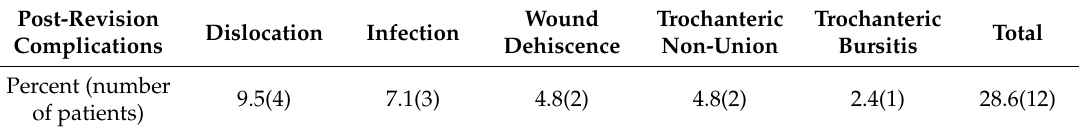
Table 6. Complications following conversion surgeries.